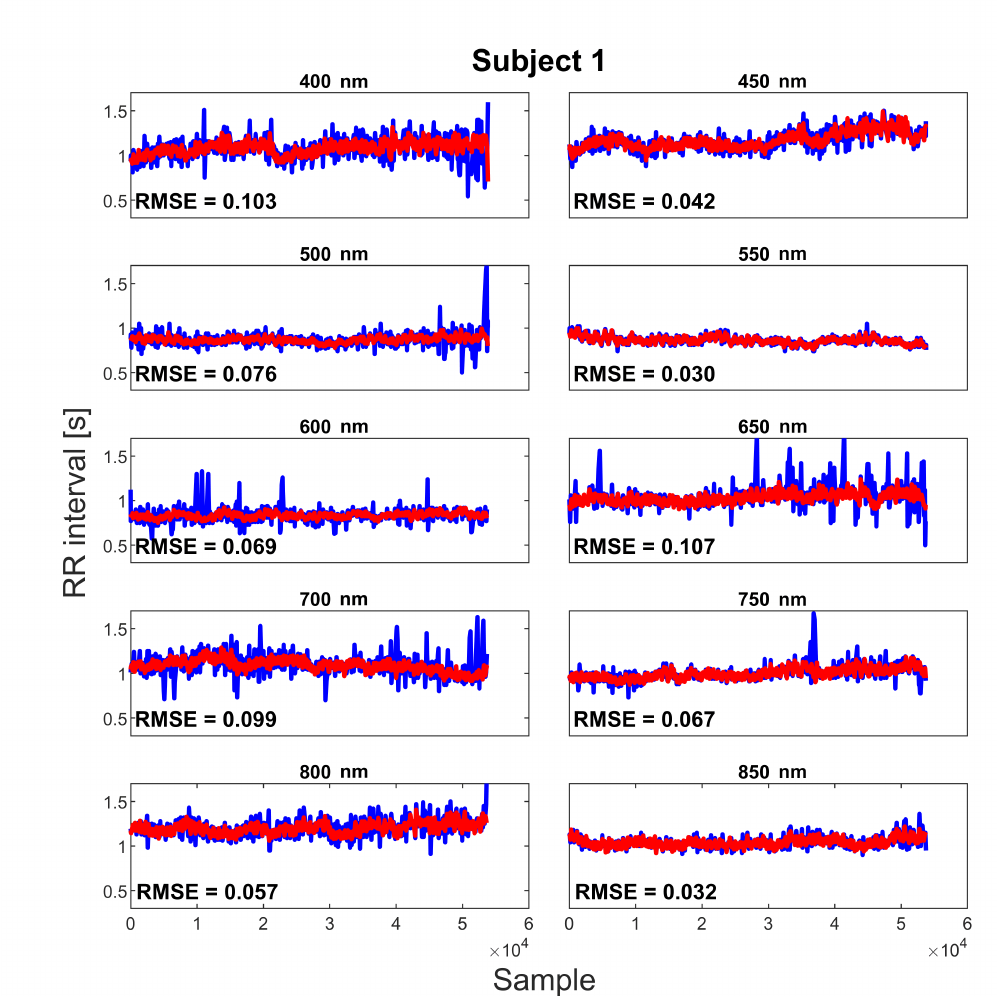
Figure 5. Example of tachogram result. Blue: tachogram extracted by pulse wave; red: tachogram calculated by ECG